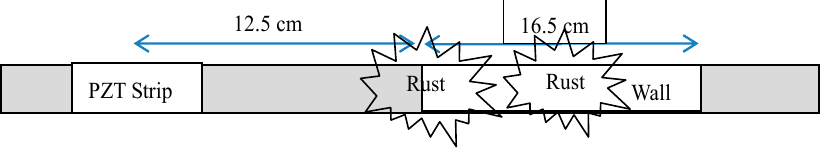
Figure 8. Schematic diagram of experimental setup for on-site testing of pipes carrying gas to residential buildings.